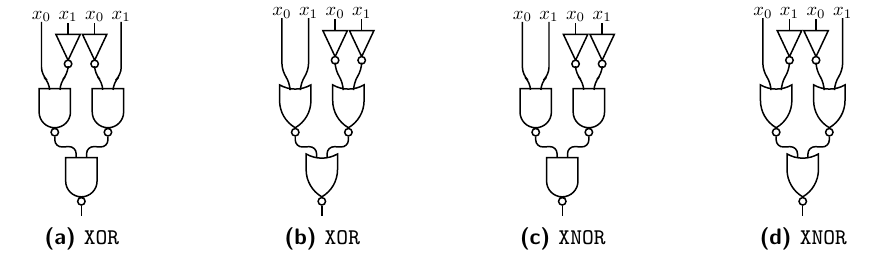
Figure 5: The equivalent sub-circuits for 2-bit XOR and XNOR gates in the basis of 2-bit NAND , NOR and INV